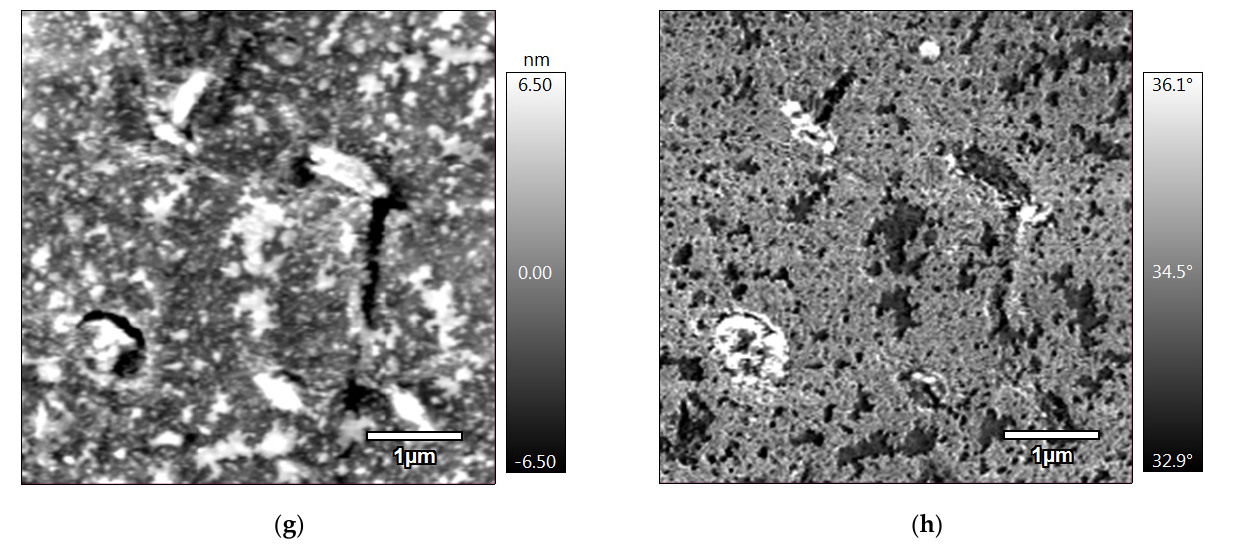
Figure 4. AFM topography and phase images of ( a , b ) PLA-JD/PHB-J, ( c , d ) 95(PLA-JD/PHB-J)5BYK, ( e , f ) PLA-JD/PHB-J-3D, and ( g , h ) 95(PLA-JD/PHB-J)5BYK-3D.